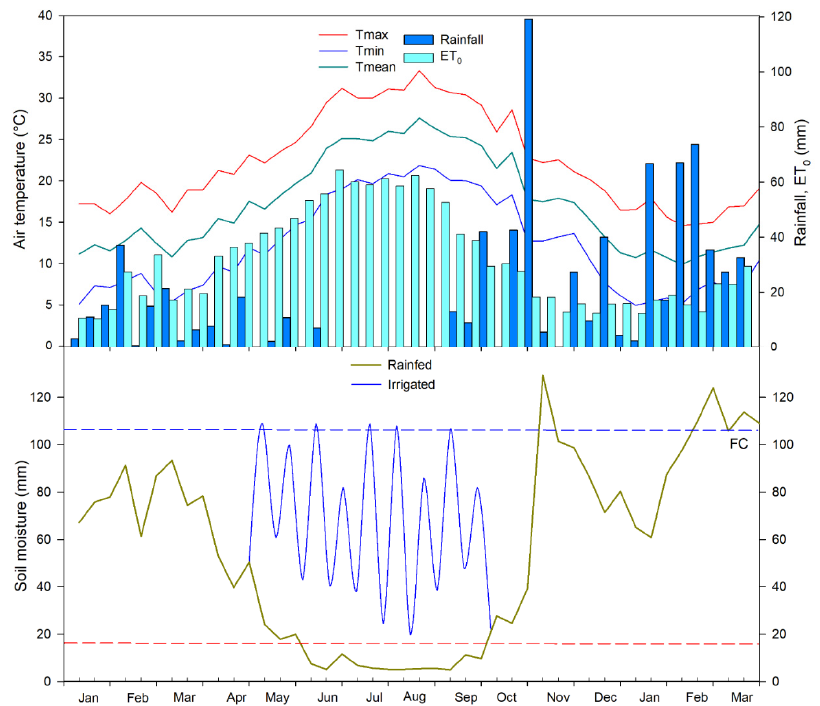
Figure 1. Meteorological trend [maximum, mean and minimum air temperatures (°C), rainfall and reference evapotranspiration (mm)], and modelled soil moisture (mm) in rainfed and irrigated plots through the growing season (February 2014 to February 2015) at the Experimental Farm of the University of Catania (10 m a.s.l., 37°25 ′ N lat., 15°03 ′ E long.). The blue dashed line shows the field capacity (FC), while the red dashed line the 20% maximum plant available water below which the crop is considered to be water stressed.